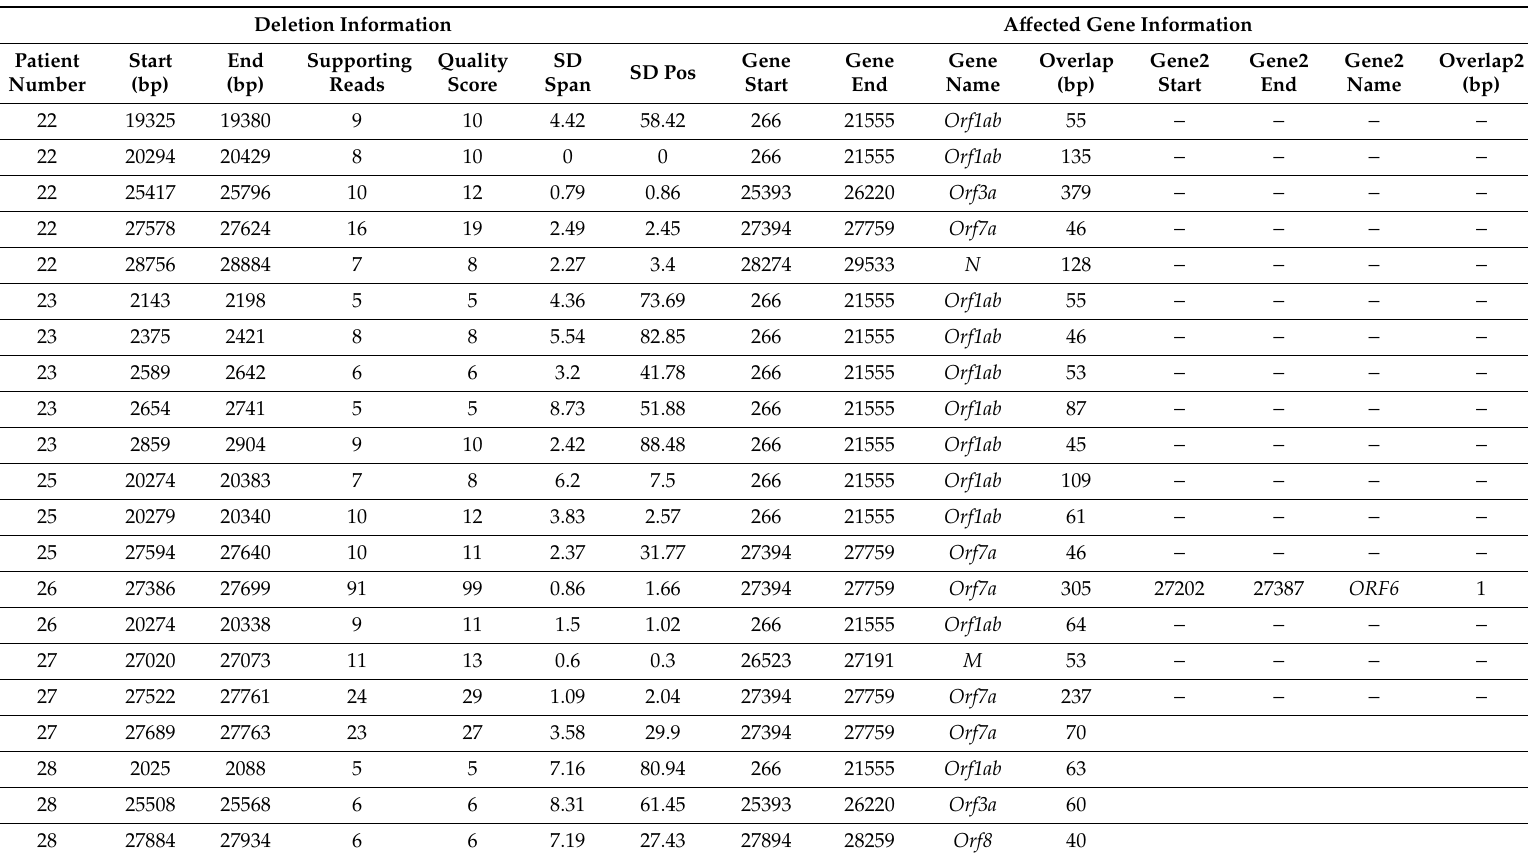
Table 2. Analysis of deletions in the SARS-CoV-2 genome in patients with COVID-19. The columns from left to right are as follows: sample barcode, deletion start position (bp), deletion end position (bp), number of reads supporting this deletion, quality score (similar to number of reads supporting, but also takes into account read mapping quality scores with a score greater than 10 having higher confidence), standard deviation (SD) of deletion span (bp) from supporting reads, SD of deletion position (bp) from supporting reads. If the deletion interrupts a gene, these are the coordinates of the gene, the gene name, and the bp overlap with the deletion. In cases where the deletion overlaps > 1 gene, the information of the second gene is